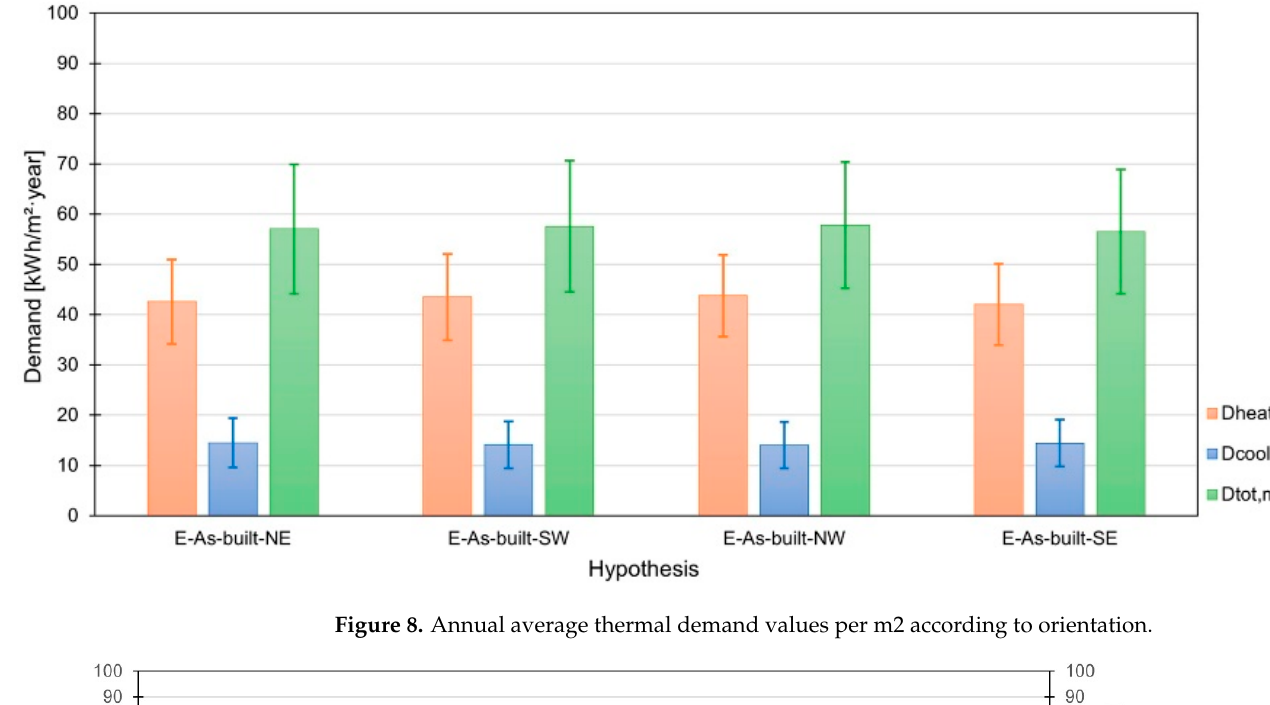
Table 4. Annual thermal demand values obtained for the as-built configuration.